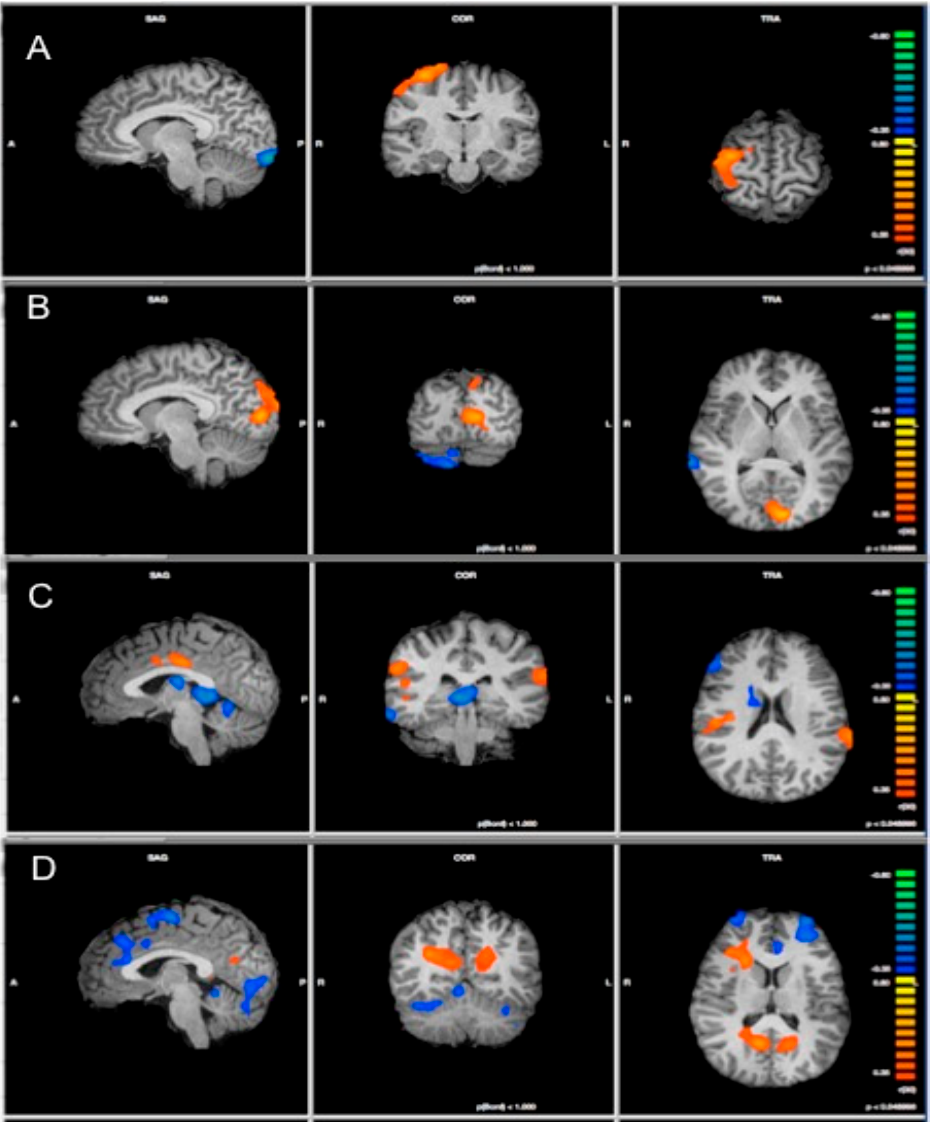
Figure 1. Results of analysis of covariance (ANCOVA) showing regions of significant correlation between trait emotional empathy scores and the functional connectivity within each of the four components representing the networks: ( A ) Default Mode; ( B ) Salience; ( C ) Left Central Executive, and ( D ) Right Central Executive network. Positive correlations are indicated in orange while negative correlations are indicated in blue. Maps are displayed at p < 0.05 with a cluster threshold estimator applied to reduce false positives. Table 1. Brain regions showing correlation of trait empathy questionnaire scores with functional connectivity values within the Default Mode Network, Salience Network, left Central Executive Network, and right Central Executive Network components. Talairach coordinates for the peak voxel in each cluster are given. Right (R) and left (L) sides of the brain are indicated; BA denotes Brodmann Area, if applicable, and the number of voxels in each of the clusters with corresponding r -and p - values.